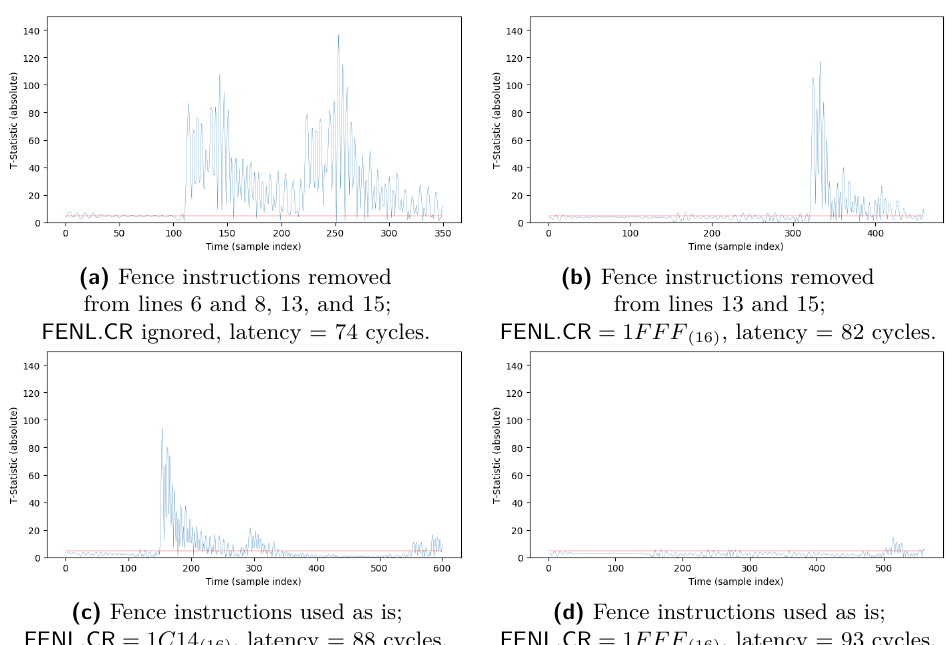
Figure 7: Results for experiment 2, relating to leakage from Figure 6 as executed on the SCARV core (randomisation-based flush semantics, bubbling variant). Note that the t-statistic is plotted in absolute form; the plots are cropped wrt. the target kernel, which has a longer latency post -insertion of fence